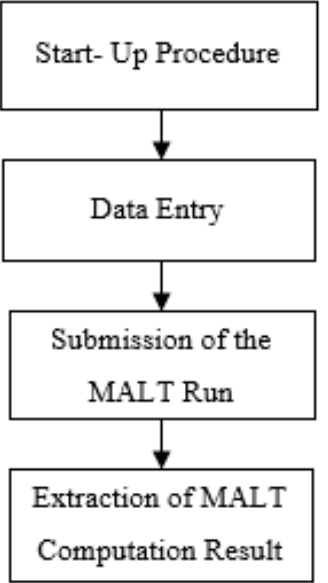
Figure 6. Flow of the earthing design model.